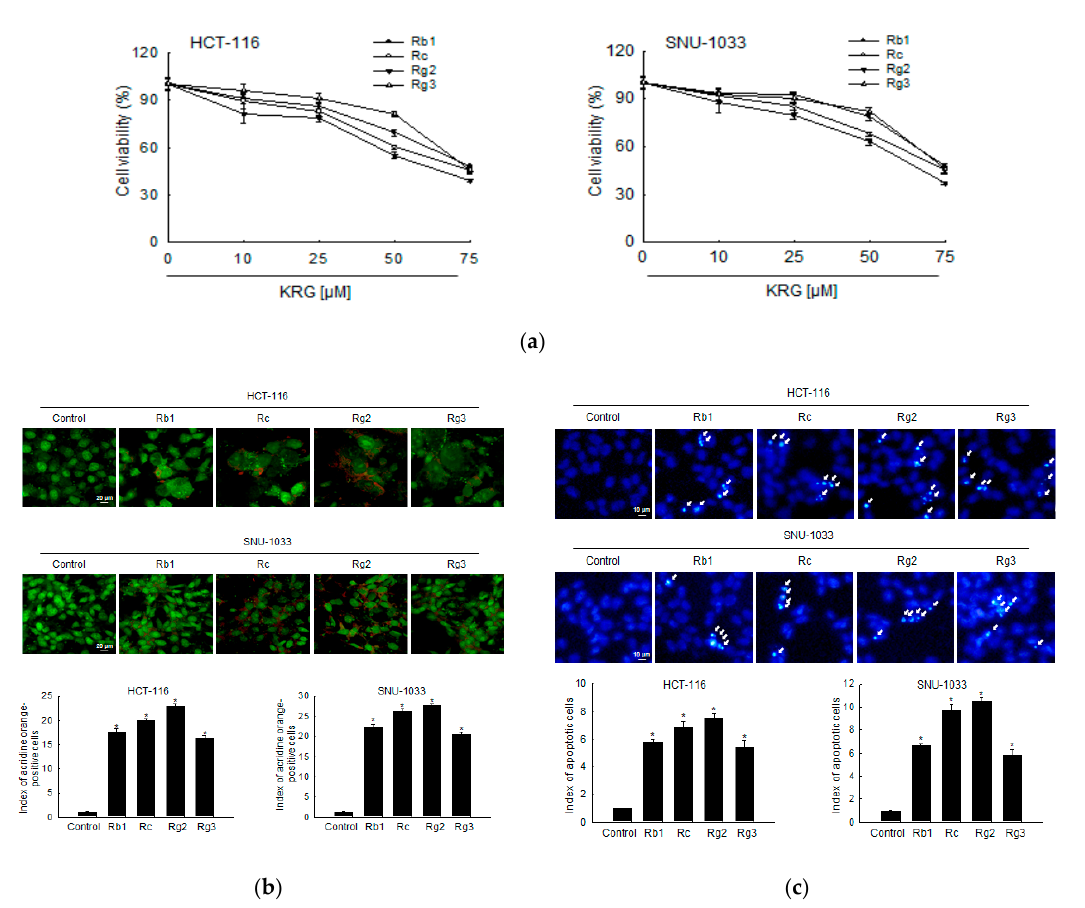
Figure 5. Ginsenoside Rg2 of KRG is the most effective component responsible for KRG-induced autophagy- and apoptosis-mediated cell death of colon cancer cells. ( a ) HCT-116 and SNU-1033 cells were treated with Rb1, Rc, Rg2, and Rg3 for 48 h, and an MTT assay was assessed. HCT-116 and SNU-1033 cells were treated at 50 μ M of Rb1, Rc, Rg2, and Rg3 for 48 h. ( b ) Autophagy was analyzed using fluores- cence microscopy after staining with acridine orange. Scale bar, 20 μ m. * p < 0.05 vs. untreated control. ( c ) The formation of apoptotic cells was assessed and quantified after staining of the cells with Hoechst 33342. Apoptotic cells are indicated by arrows. Scale bar, 10 μ m. * p < 0.05 vs. untreated control .